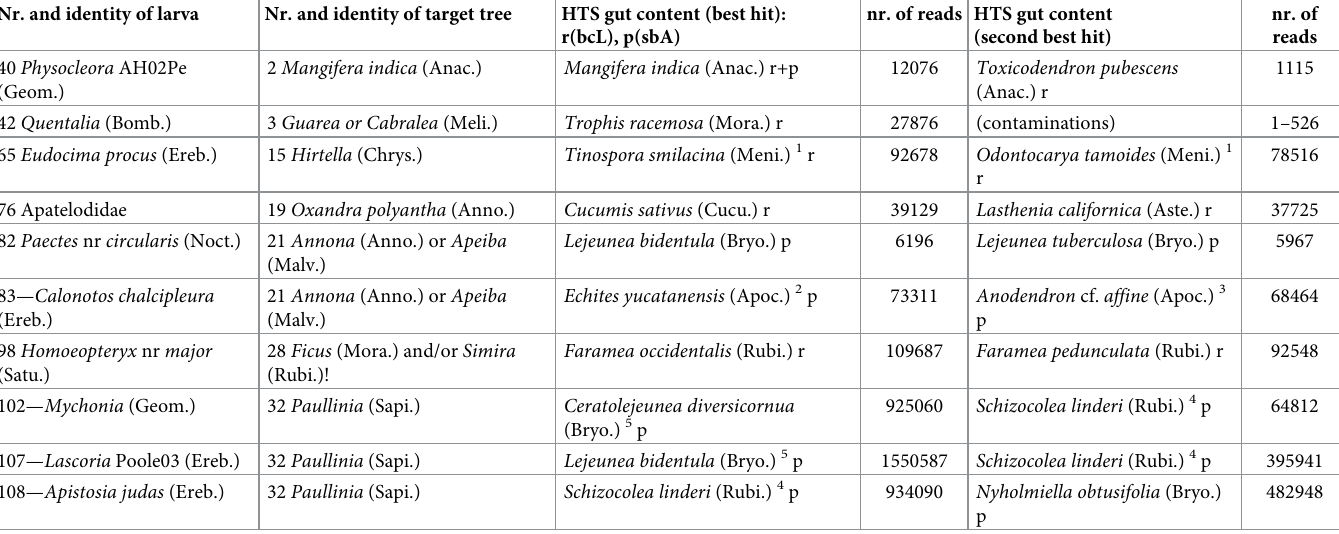
Table 4. Gut contents of ten fogged larvae with identity of target tree and HTS results from molecular identification of gut content, only the BLAST identification of the fragments with the two most numerous reads shown. Nr. and identity of larva Nr. and identity of target